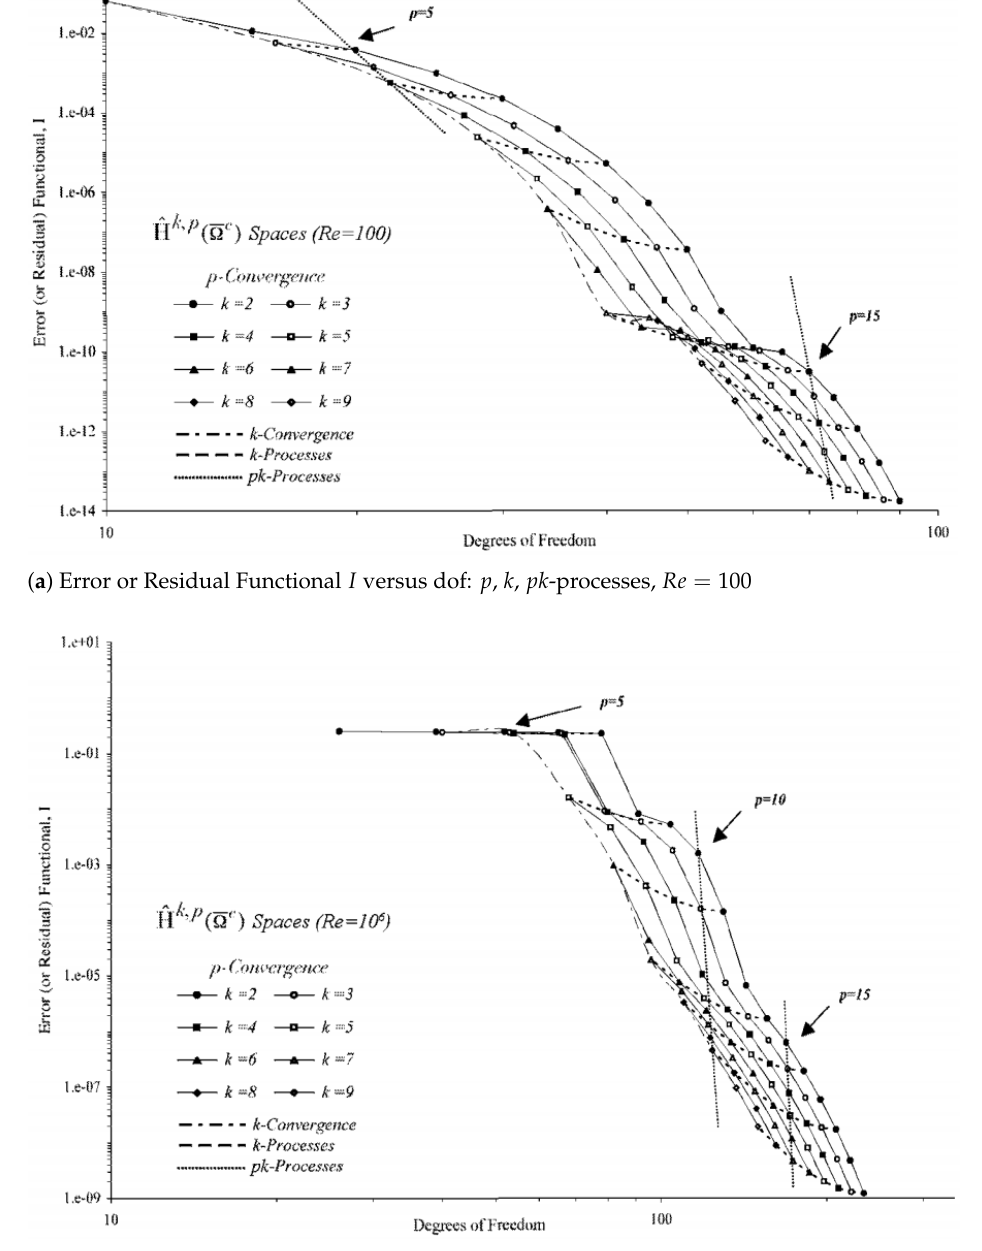
Figure 13. Graphs of I versus dof for Burgers